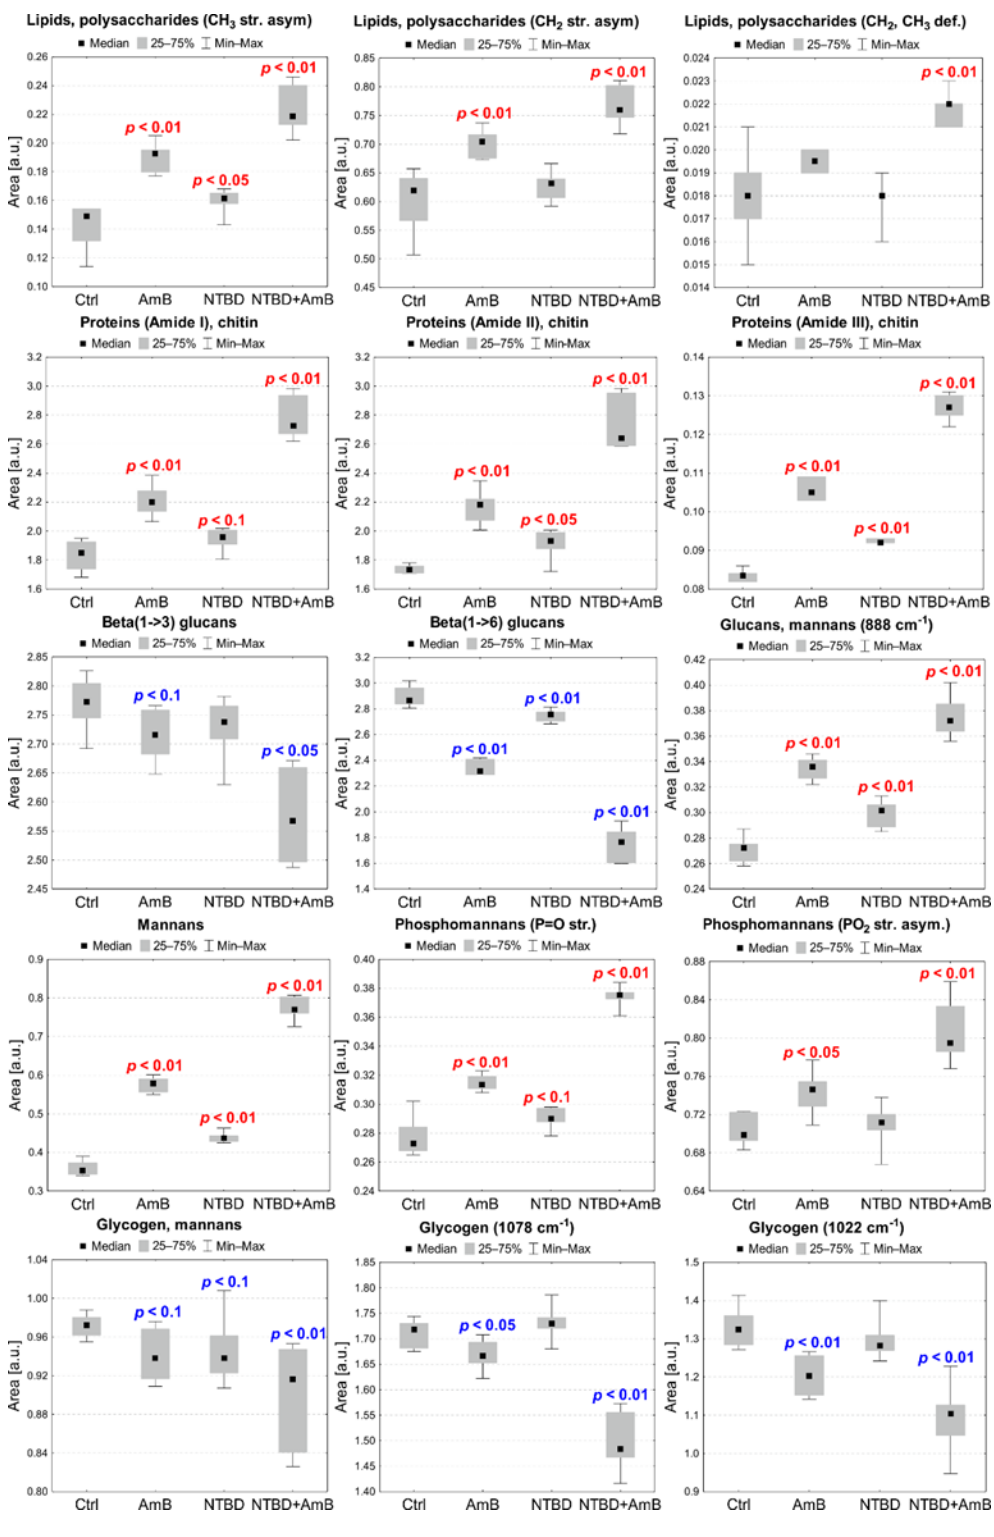
Figure 8. Median, minimal, and maximal values of intensities of selected absorption bands showing differences between C. albicans exposed to the AmB, NTBD, and NTBD + AmB treatments and the control (Ctrl) group. The p -values of the Mann–Whitney U test for statistically significant changes compared with the control are placed on the charts (red—increases, blue—decreases).